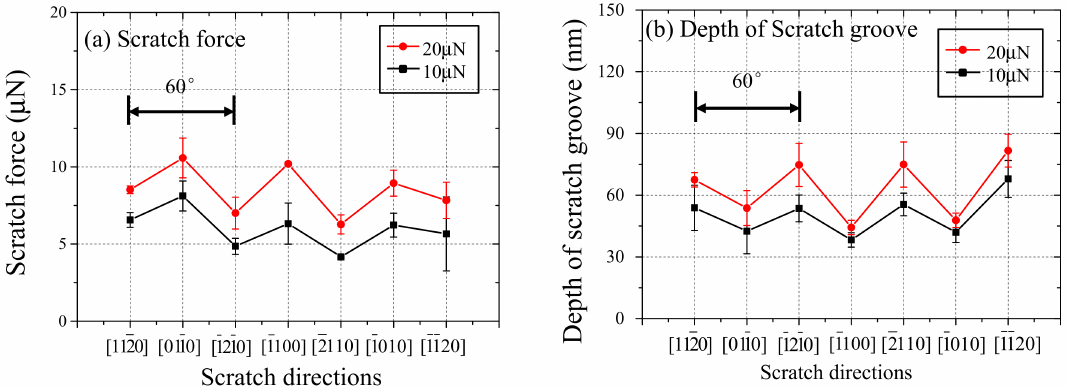
Figure 6. The relationship between scratch direction and ( a ) scratch force and ( b ) depth of scratch groove, respectively.